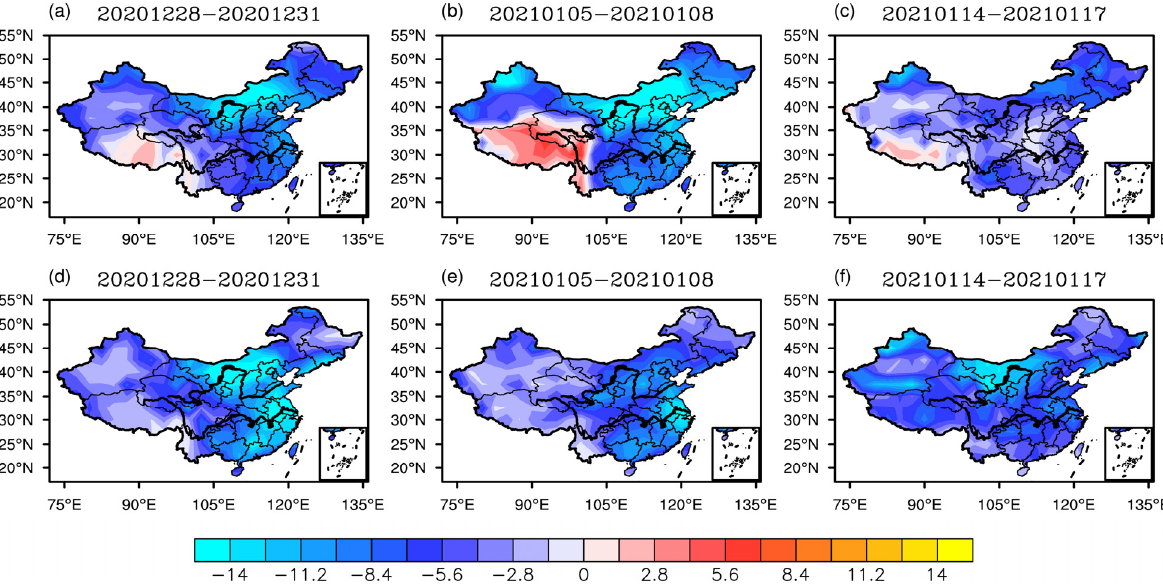
Figure 1. ( a – c ) Temperature anomaly and ( d – f ) cooling rate during the cold waves “1228”, “0105”, and “0114” (unit: degC).